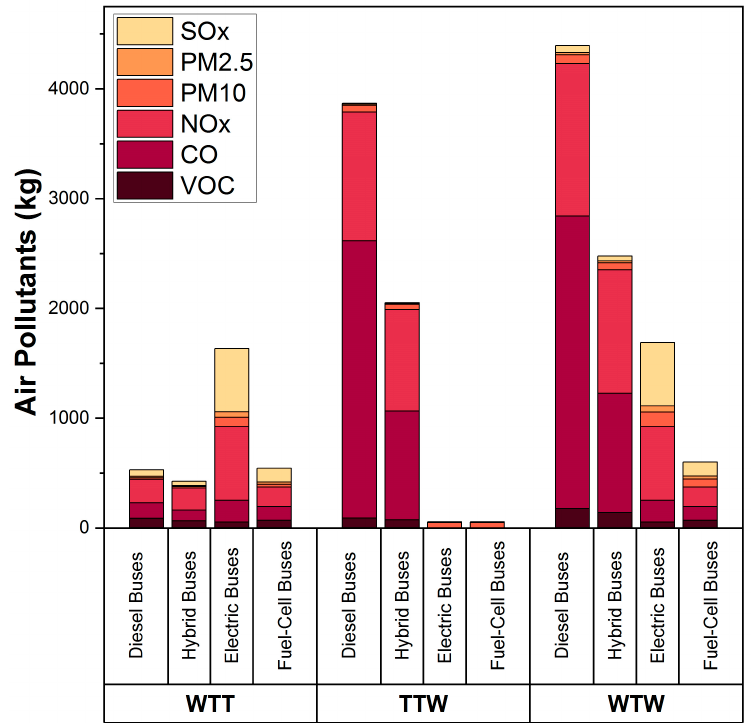
Figure 9. Daily Air Pollutant Emissions of Different Fuel Bus Technologies in Morocco.